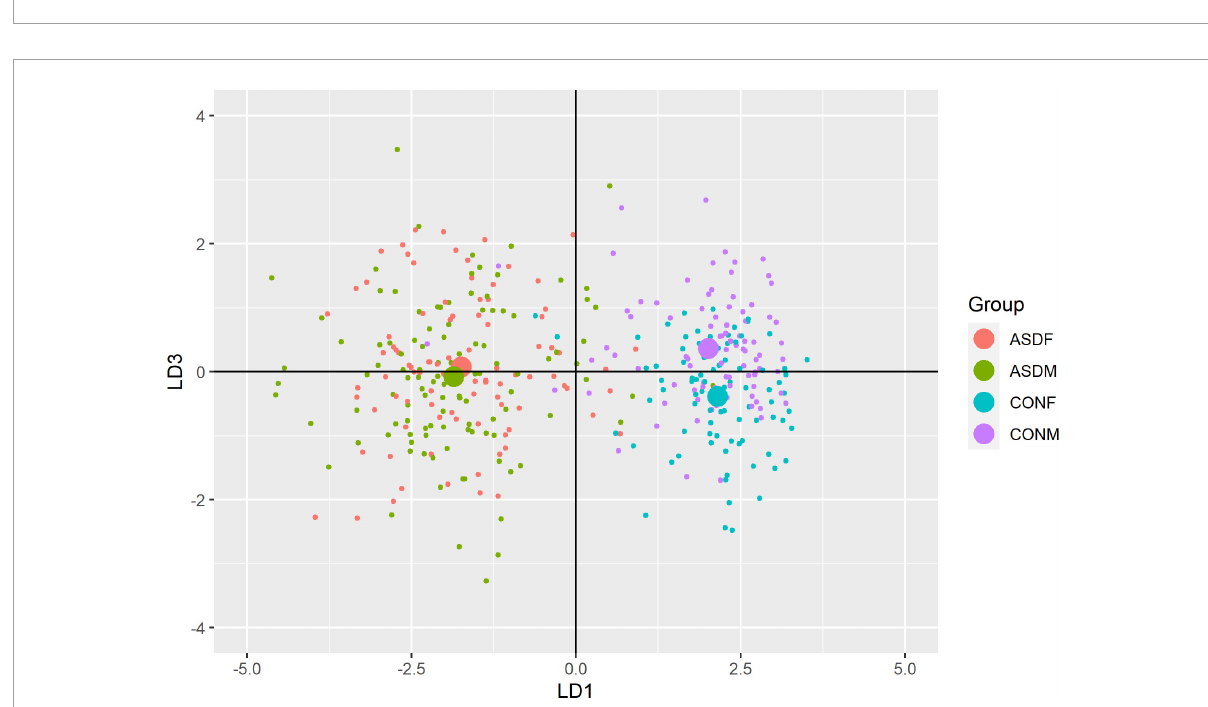
FIGURE1 Linear discriminant axis 1 plotted against linear discriminant axis 2.